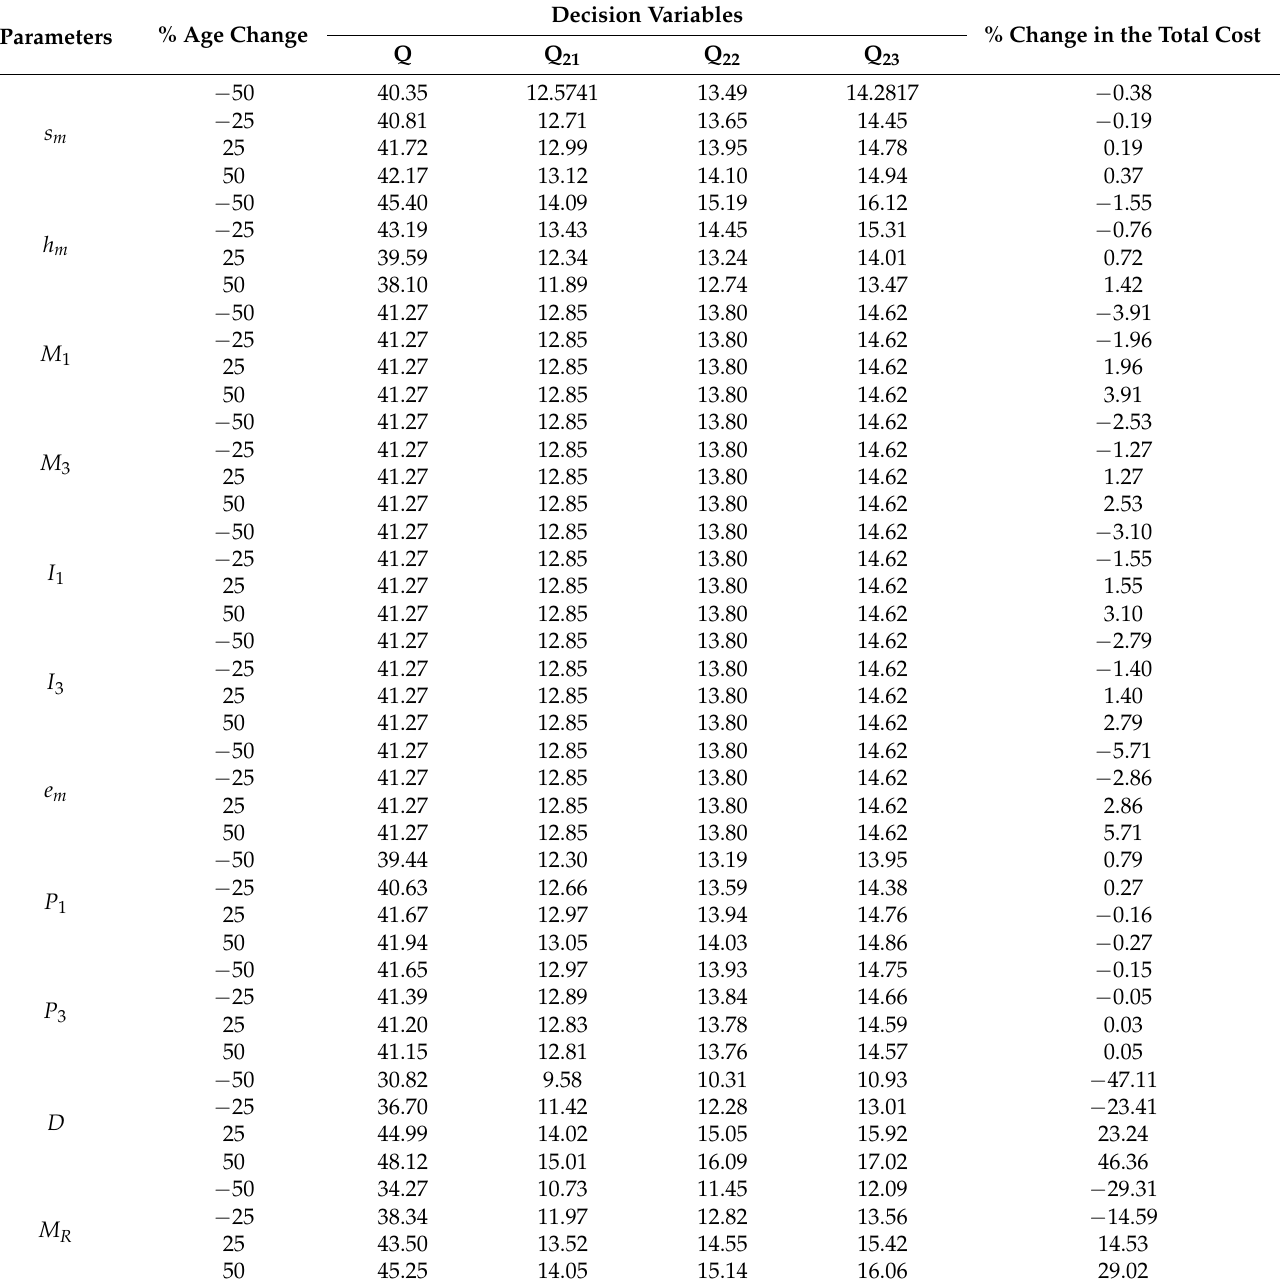
Table 5. Sensitivity analysis of input